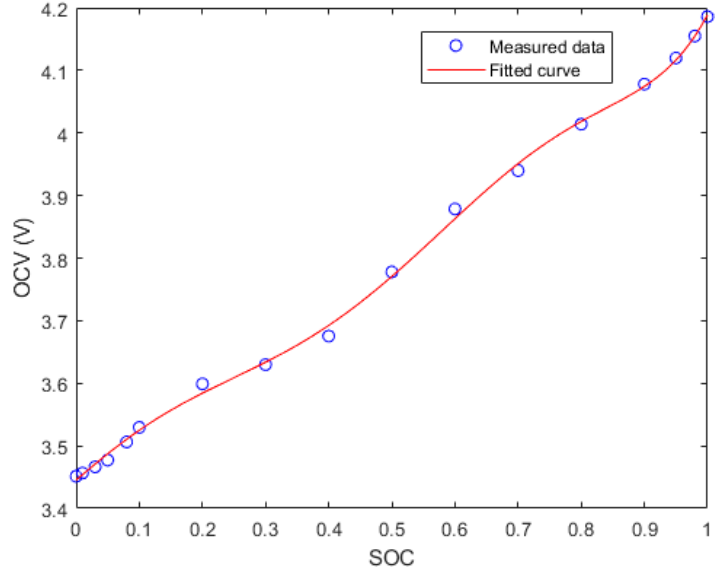
Figure 7. The measured and fitted OCV-SOC curve at 25 ℃.